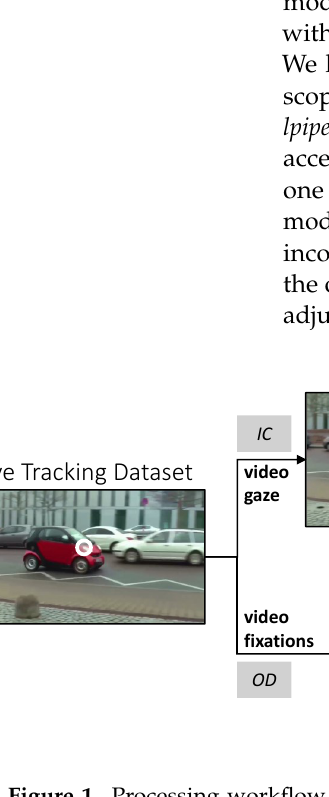
Figure 1. Processing workflow of the two proposed methods for automatic attention detection: IC is based of image classification and gaze samples, OD uses object detection and fixation events. Both methods support visual attention detection in